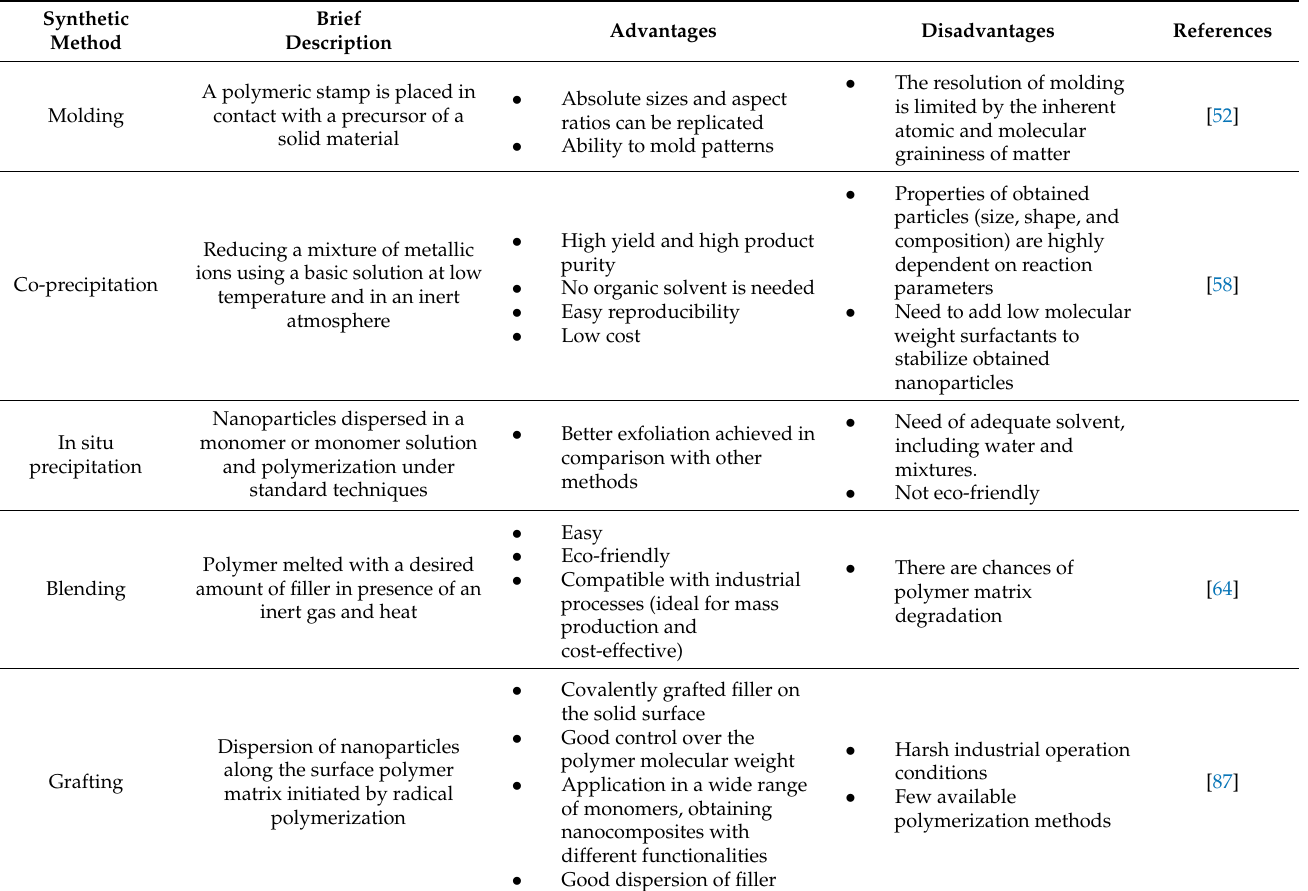
Table 1. Summary of synthetic methods for polymer nanocomposites with their advantages and